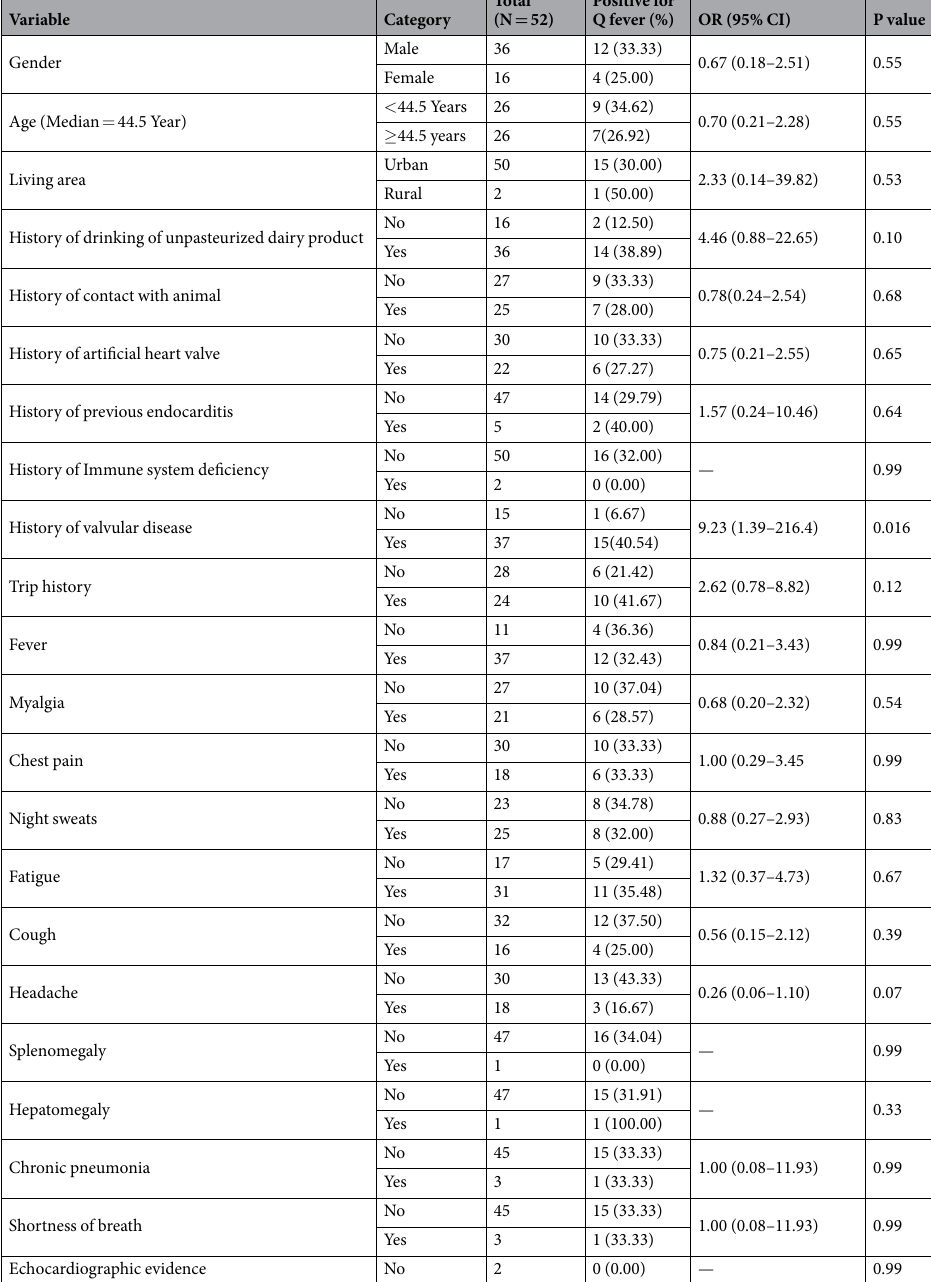
Table 1. Descriptive and analytic analysis of the association between studied variables and Q Fever result among the culture-negative endocarditis cases hospitalized in Rajaie Cardiovascular Medical and Research Center, Tehran,